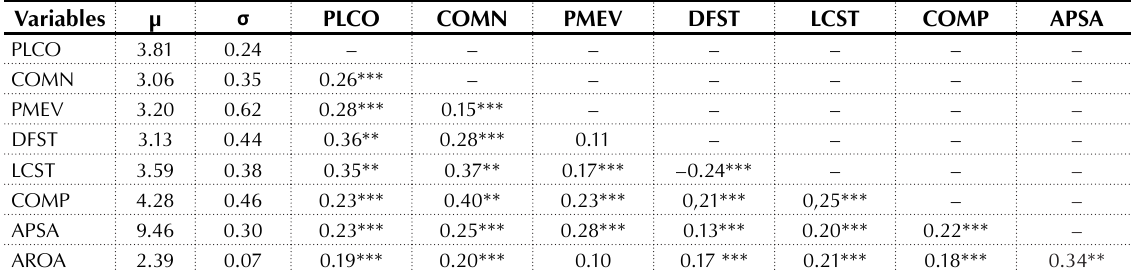
Table 3. Test of the research model and effects between variables